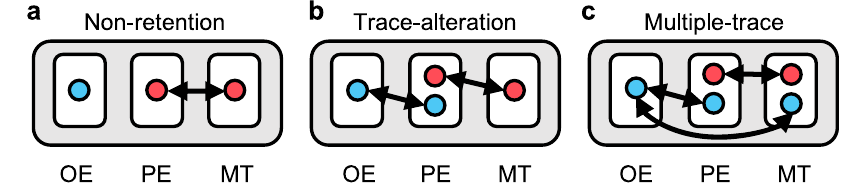
Fig. 1 | Three theoretical models of the misinformation effect. a The non- retention model. b The trace-alteration model. c The multiple-trace model. They posit different patterns of changes in hippocampal representations across the three stages of misinformation false memory (original-event [OE], post-event [PE],